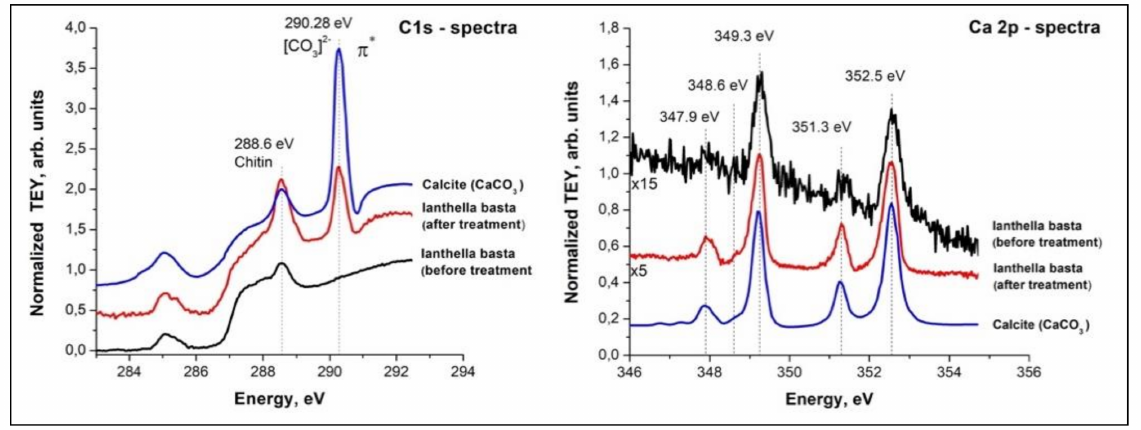
Figure 9. NEXAFS C1s (left) and Ca2p (right) spectra of I. basta skeletal fibers before and after NaOH treatment in comparison with calcite